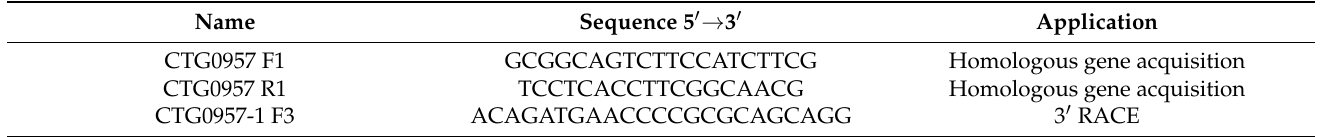
Table 2. Primer sequences used for